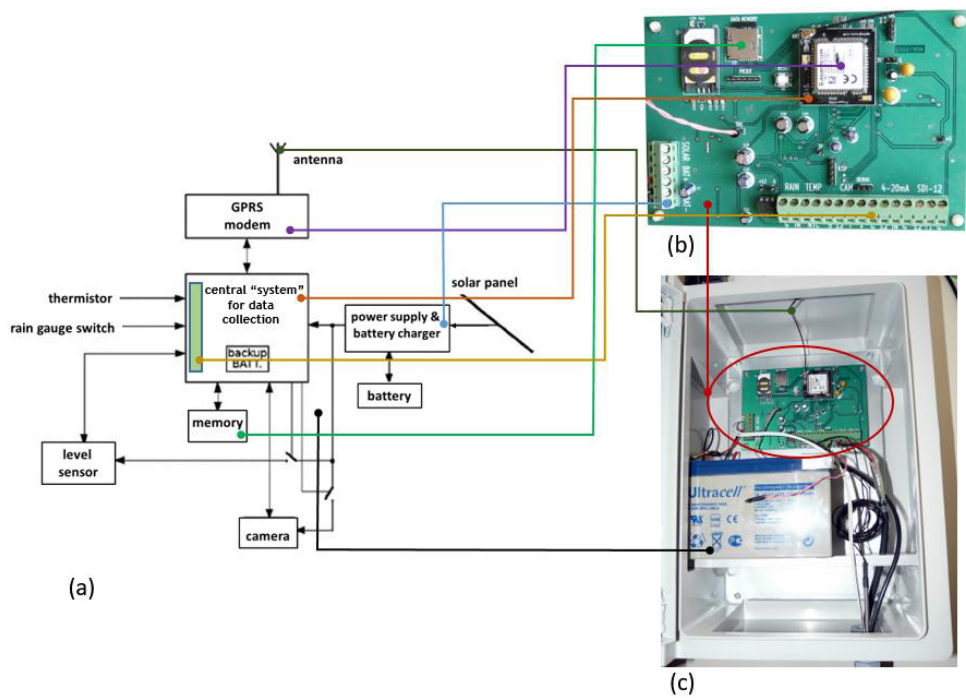
Figure 8. HYDRONET station: ( a ) block diagram, ( b ) control board, and ( c ) box interior.